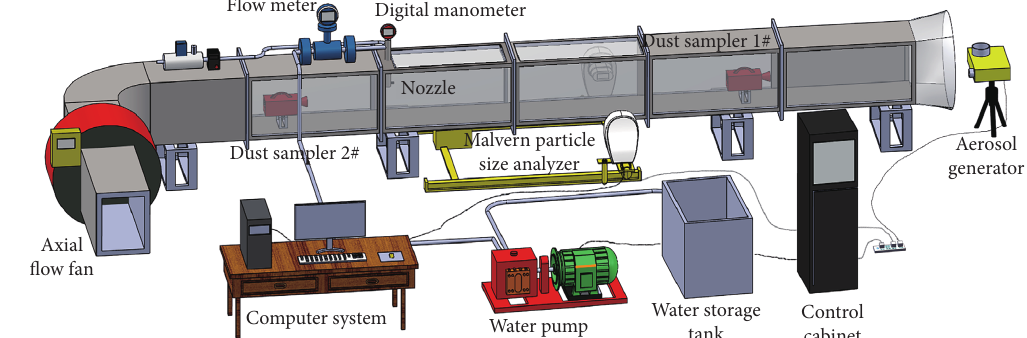
Figure 2: Dust-suppression experimental system via spraying.